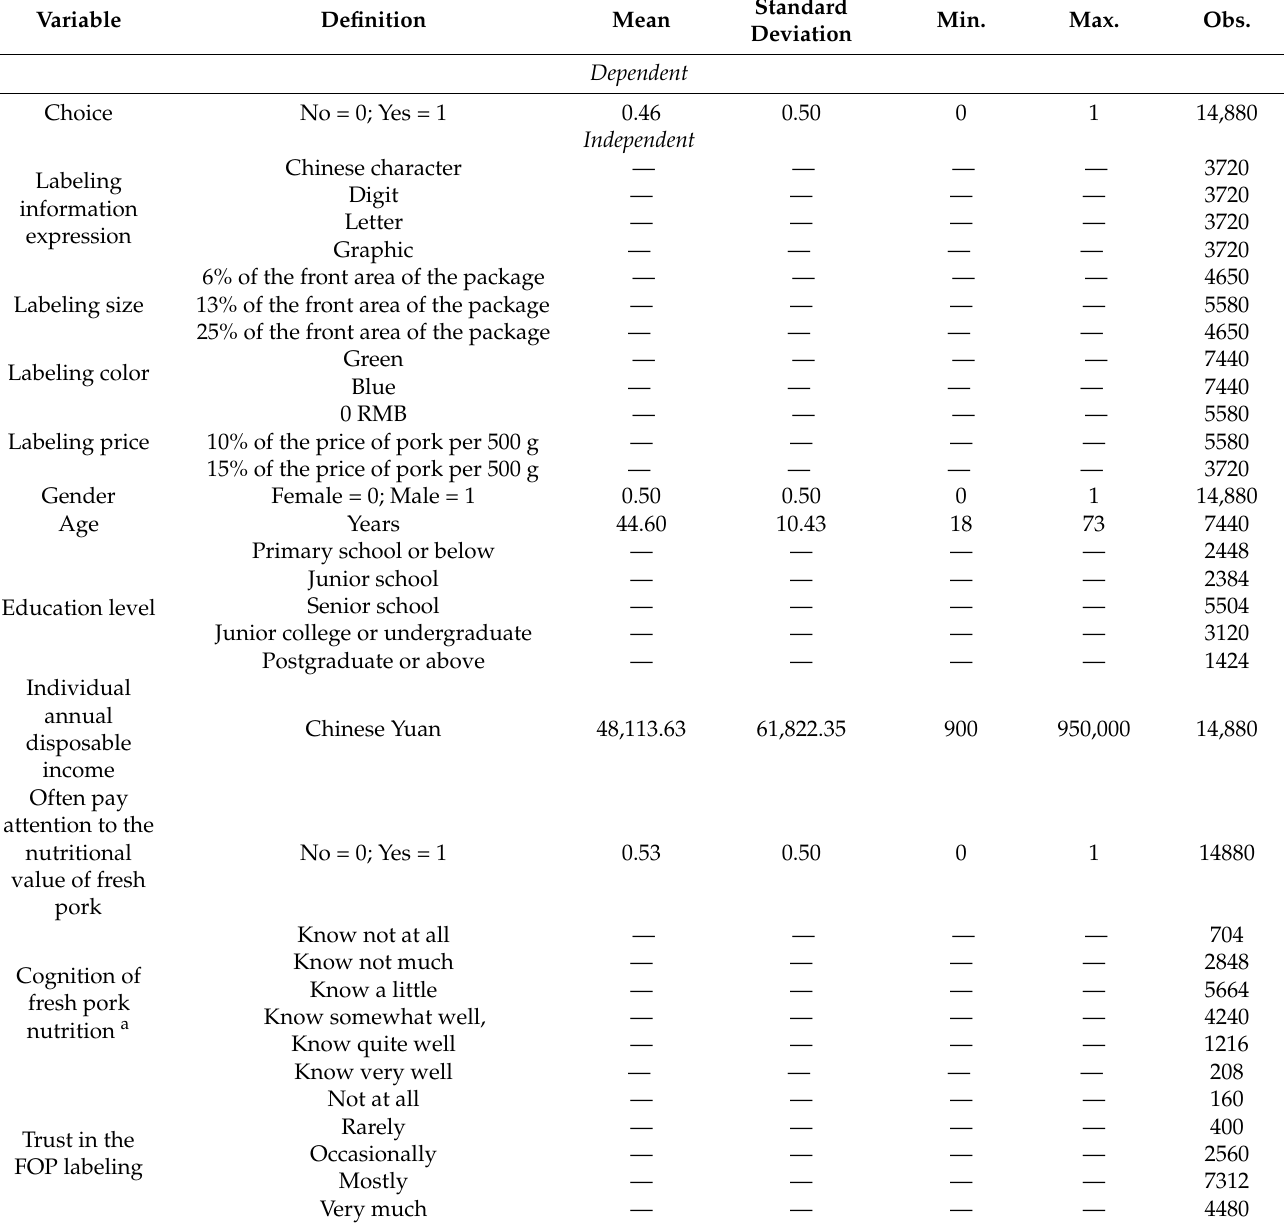
Table 4. Variables measurement and descriptive